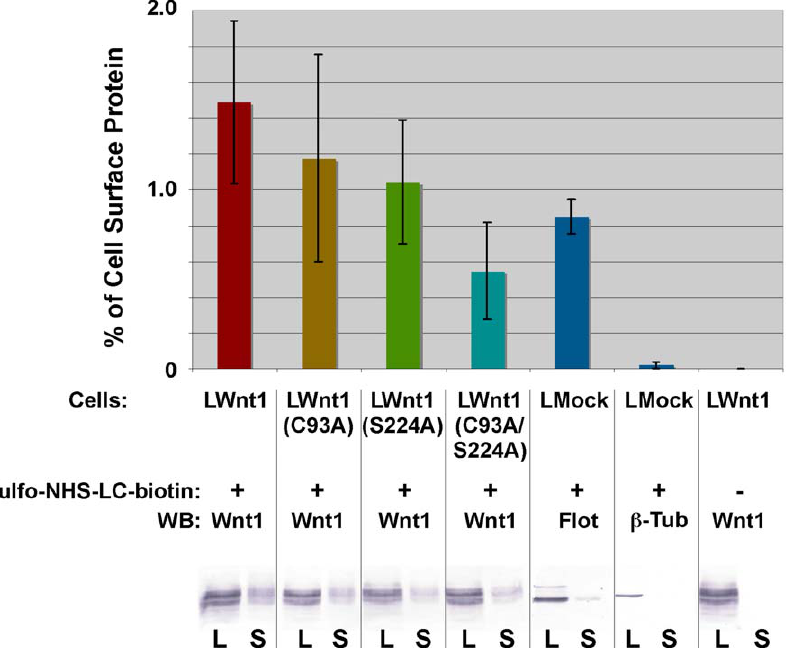
Figure 3. Lipid-deficient Wnt1 does not accumulate on the surface of L cells. L cells stably transfected with wild-type and mutant Wnt1 constructs were treated with 100 ug/ml of heparin to release Wnt1 protein bound to HSPGs. After labeling cells with Sulfo-NHS-LC-biotin, cell surface proteins (S) were immunoprecipitated using NeutrAvidin beads. Aliquots of the initial lysates (L; before immunoprecipation) and the immunoprecipitated material were subjected to SDS-PAGE, blotted onto PVDF, and probed with the indicated antibodies. We used Flotillin (cell surface) and ß-tubulin (intracellular) as internal controls. Blots were scanned and quantitated using NIH ImageJ. This experiment was replicated 6 times. Error bars represent the standard error.